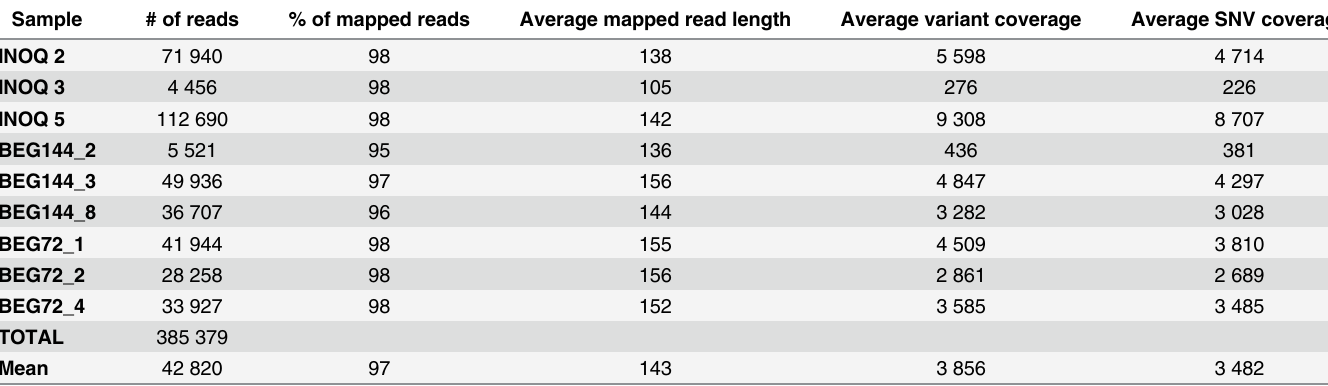
Table 1. Reads and variants statistics of the 9 R . irregularis single spores.